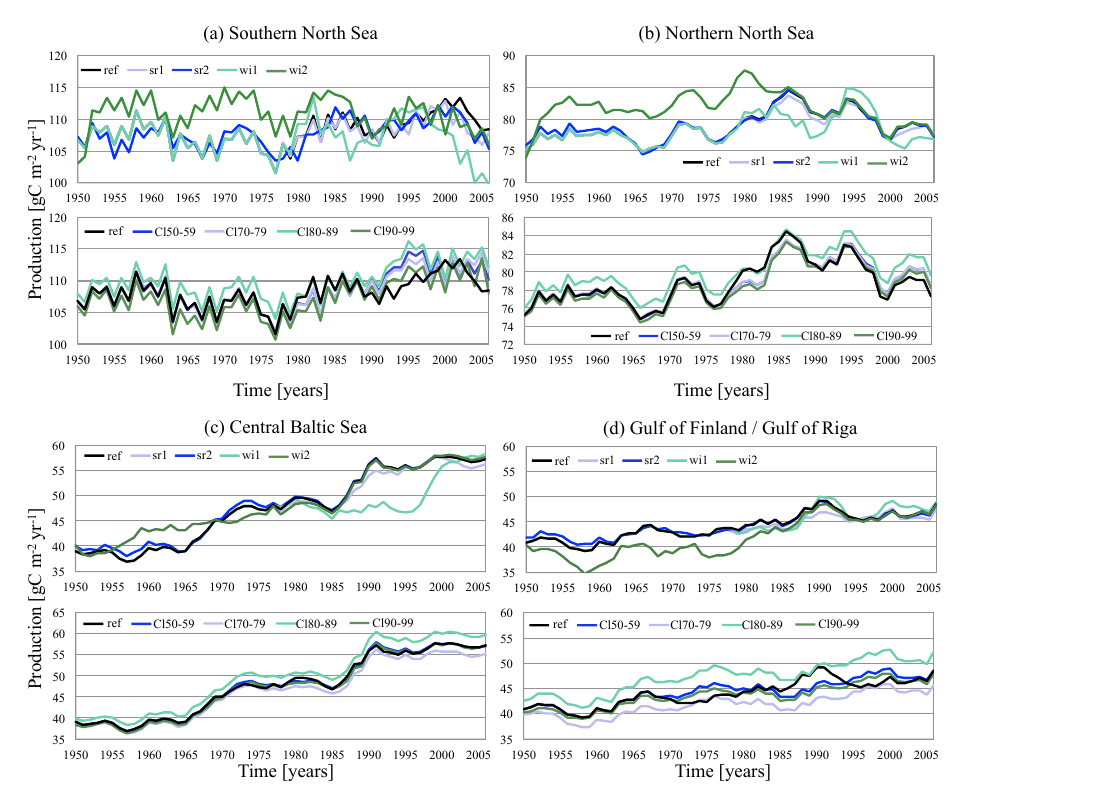
Figure 11. Estimated net primary production for the reference run (ref) and the scenario simulations concerning short-wave radiation (sr1 and sr2) and wind (wi1 and wi2) (a, b) and river nutrient load (Cl) (c, d) for two subregions in the North Sea (southern and northern North Sea) and two subregions in the Baltic Sea (central Baltic Sea and Gulf of Finland and Gulf of